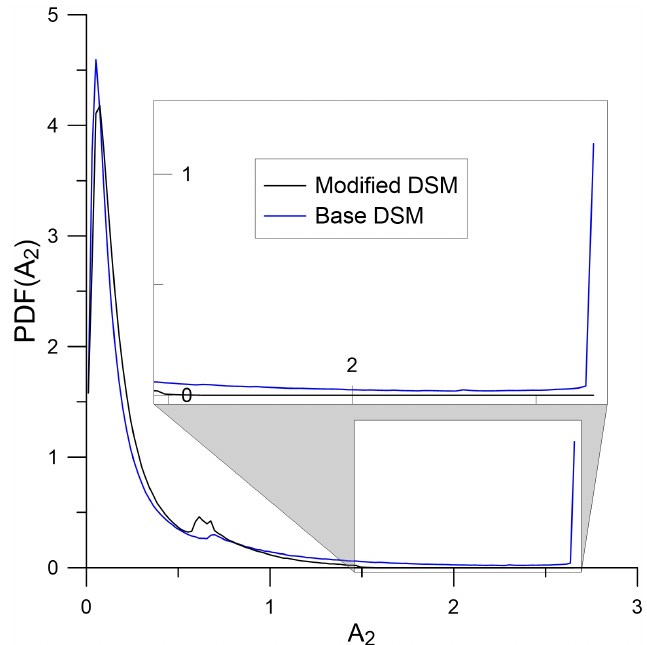
Figure 2. 𝐴 (cid:2870) probability density function with and without anisotropy invariant stabilization. Figure 2. A 2 probability density function with and without anisotropy invariant